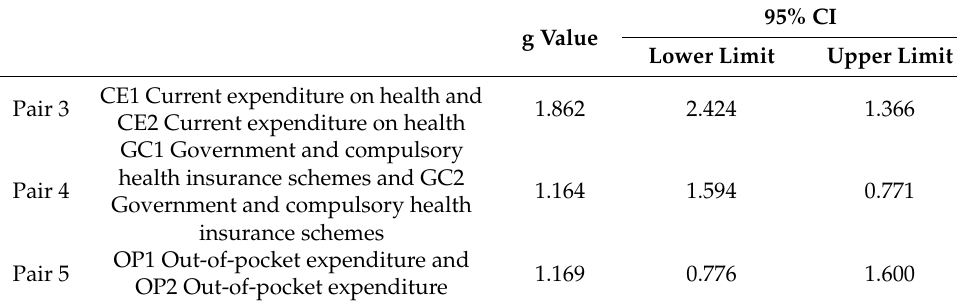
Table 6. Effect sizes for Hedge’s g dependent samples.